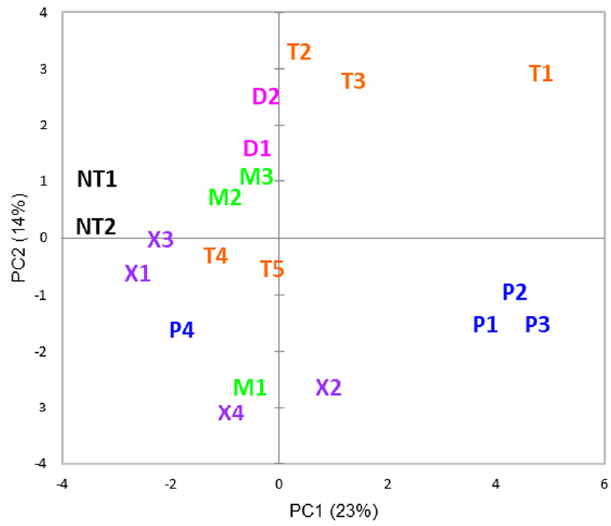
Fig. 3 Principal component plot (PC1 vs. PC2) for intensity of 20 most frequently detected compounds. Principal component analysis demonstrating the clustering of the various compounds. Source data are provided in Supplementary Information Table